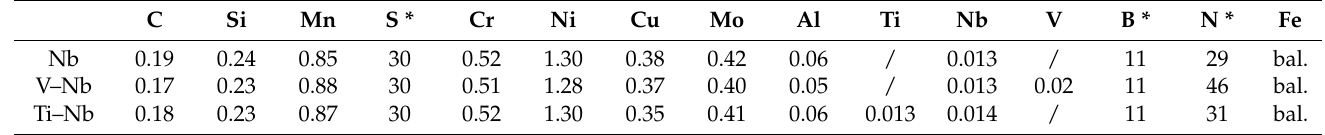
Table 1. Chemical composition of the studied S1100QL steels (wt